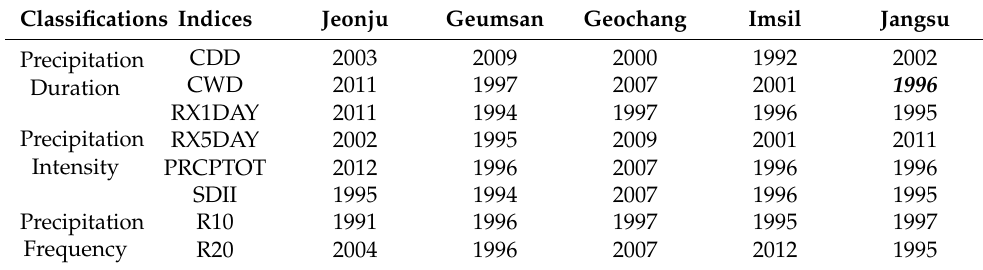
Table 4. Results of MWP test to detect change points in precipitation indices. Classifications